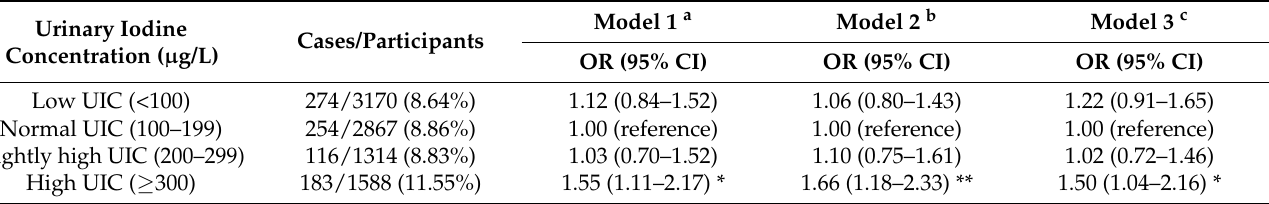
Table 2. Weighted ORs and 95% CIs of depressive symptoms according to urinary iodine concentration.